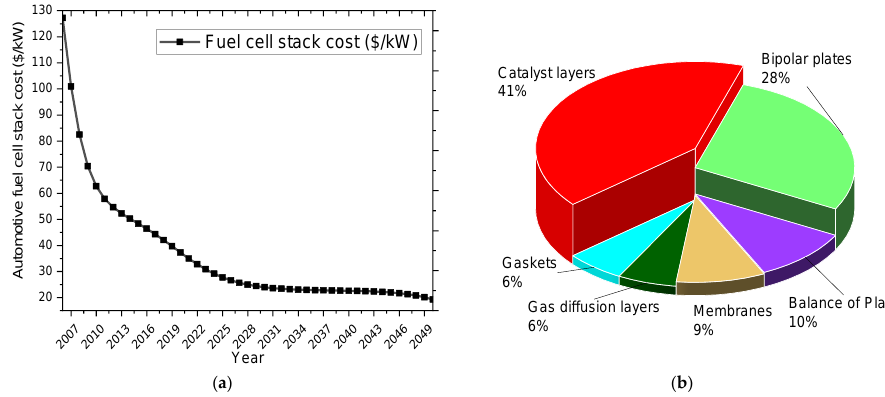
Figure 4. The share of different components of the fuel stack in the overall cost: ( a ) The overall automotive fuel-cell stack cost from 2006 to 2050, with projections from 2022 to 2050, ( b ) the share of the components of the fuel cell in the overall cost [45].